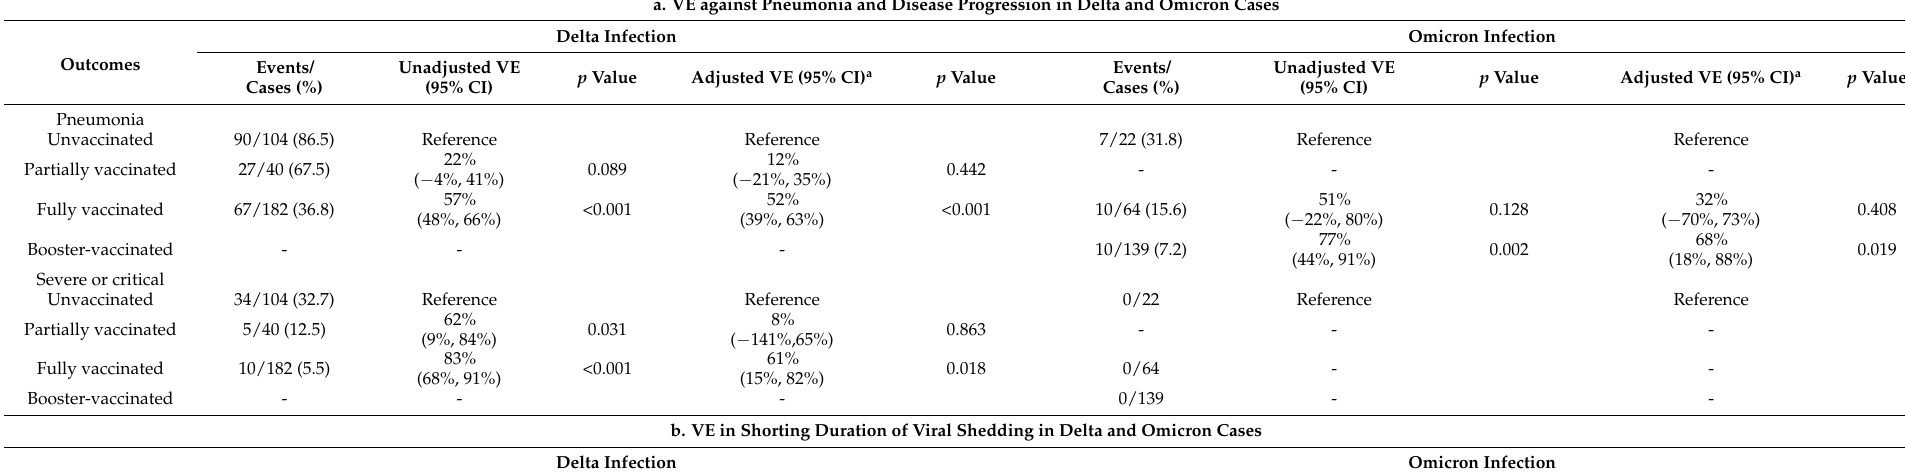
Table 4. VE in cases infected with Delta and Omicron